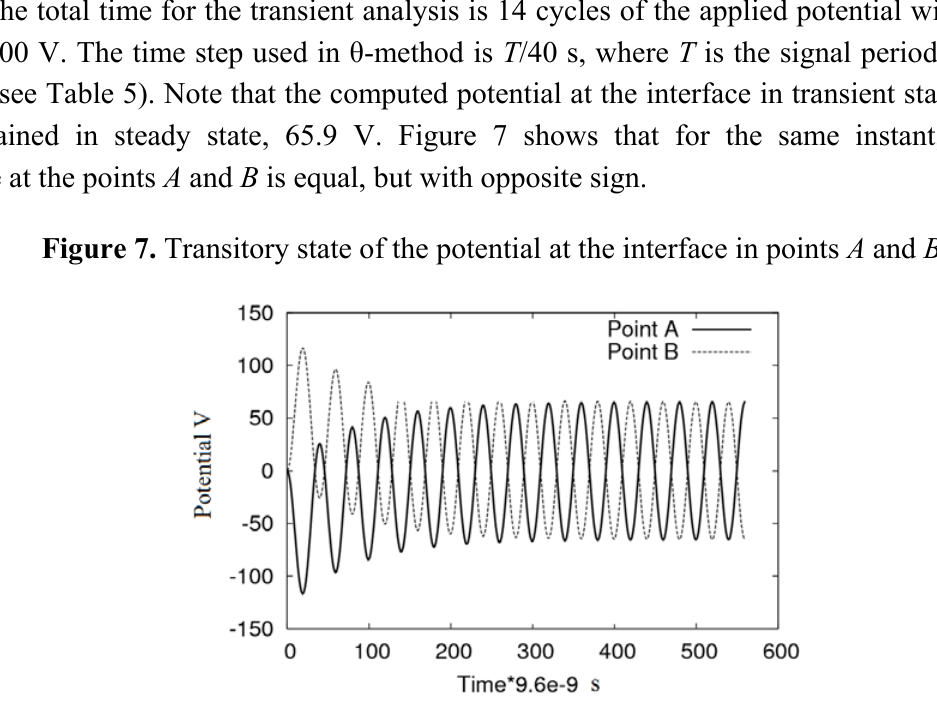
Figure 8. Transitory state of the micromotor : potential distribution at the interface for instant t